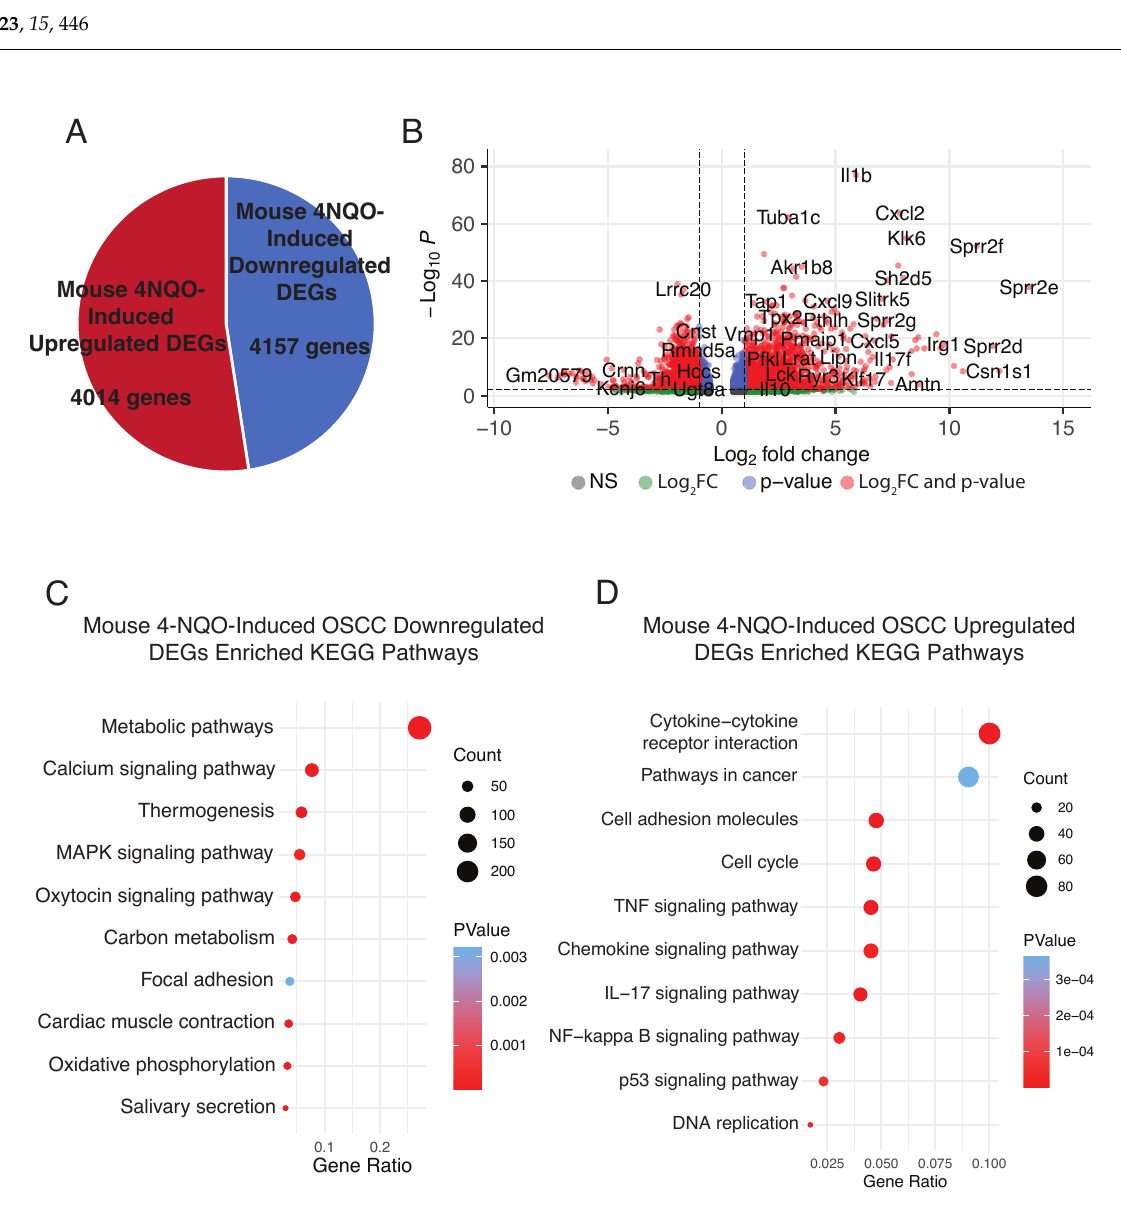
Figure 5. Investigating the p63-driven gene signature in an independent 4NQO-induced mOSCC model. A pie chart ( A ) and a volcano plot ( B ) of DEGs in the dataset by Tang et al. [11]. Enriched KEGG pathways in downregulated ( C ) and upregulated ( D ) DEGs from the dataset by Tang et